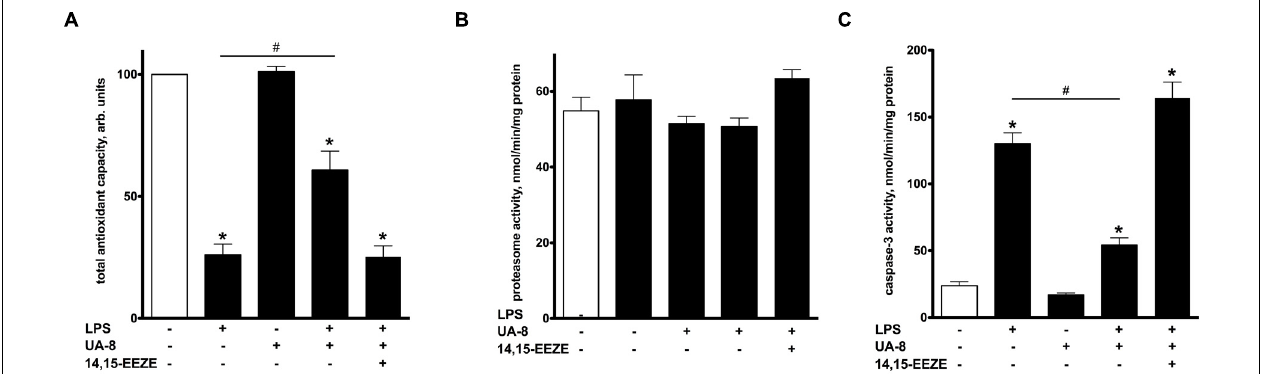
proteasome activity after treatment either with UA-8 or with LPS. (C) UA-8 prevented LPS-induced activation of caspase-3. Values are represented as mean ± SEM, N = 3–4. Significance was set at P < 0.05. * Significantly different from control. # Significantly different from LPS-treated cells.